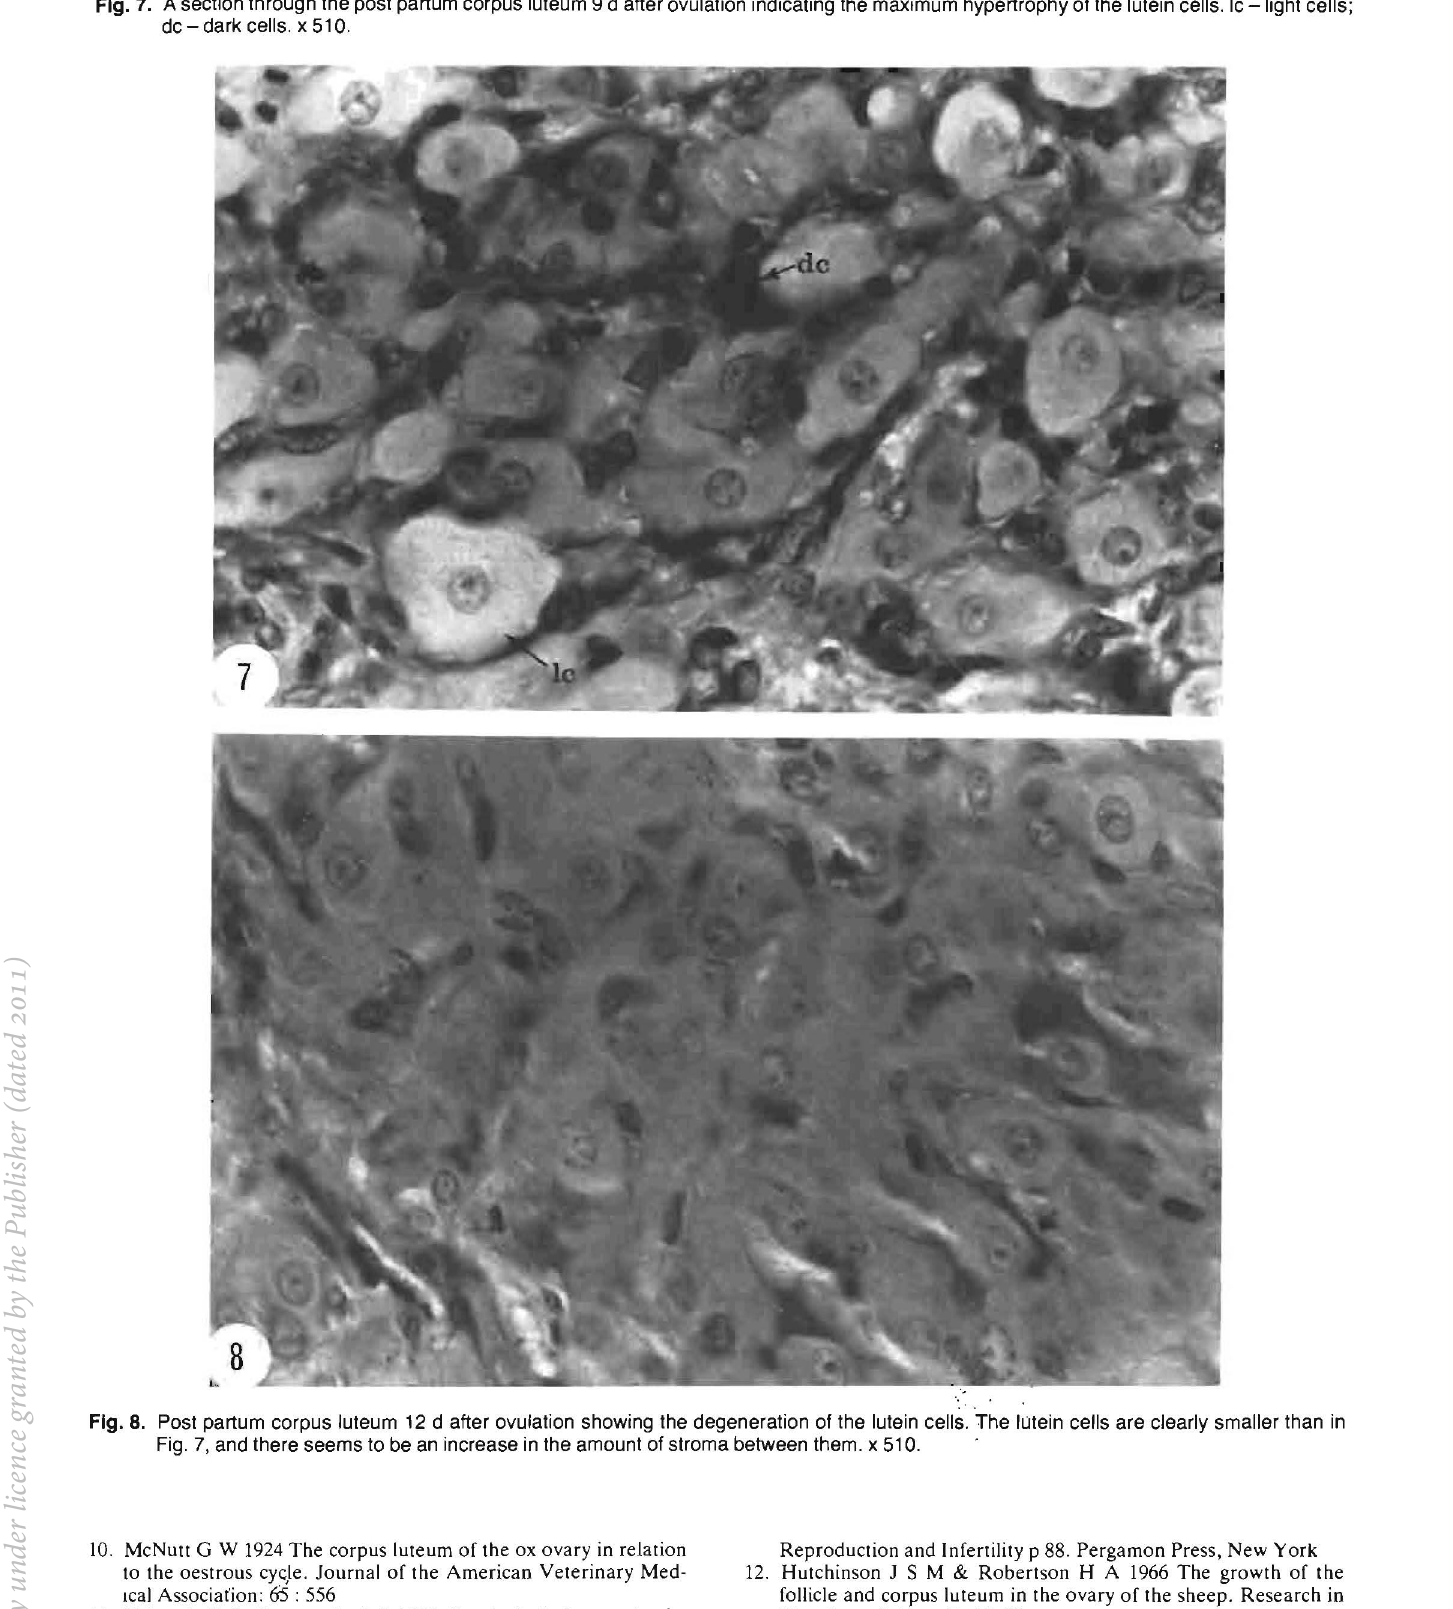
10. McNutt G W 1924 The corpus luteum of the ox ovary in relation to the oestrous cycle. Journal of the American Veterinary Med Ical Associat'ion: 65 : 556 11 Foley R C &·Greenstein J S 1958 Cytological changes in the bovine corpus 1uteum during early pregnancy. F. X. Gassner